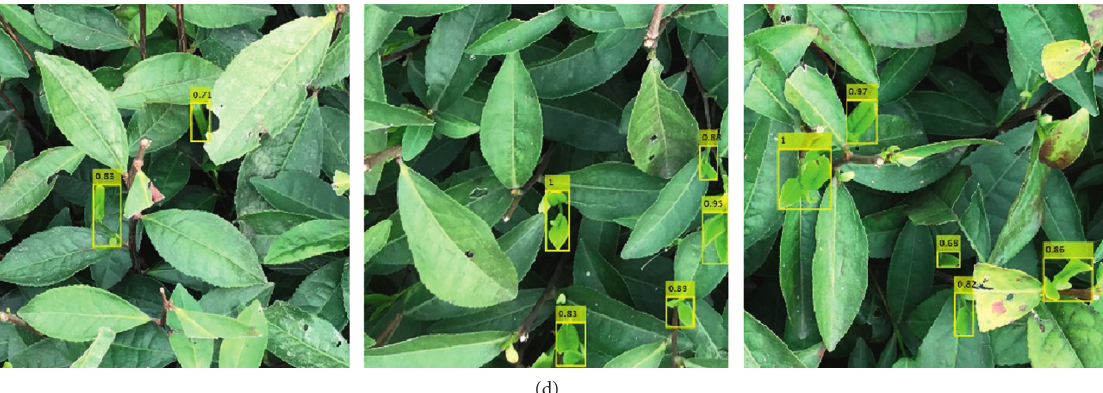
Figure 3: Detection results obtained by the R–FCN (ResNet50 backbone), conventional SSD (ResNet50 backbone), FSSD, and the proposed FTSD-IEFSSD; the leaves in the yellow boxes are the detected fresh tea sprouts, and an IoU threshold with a score of 0.5 or above is drawn. (a) Detection results obtained by the conventional SSD (ResNet50 backbone). (b) Detection results obtained by the R–FCN (ResNet50 backbone). (c) Detection results obtained by the FSSD. (d) Detection results obtained by the proposed